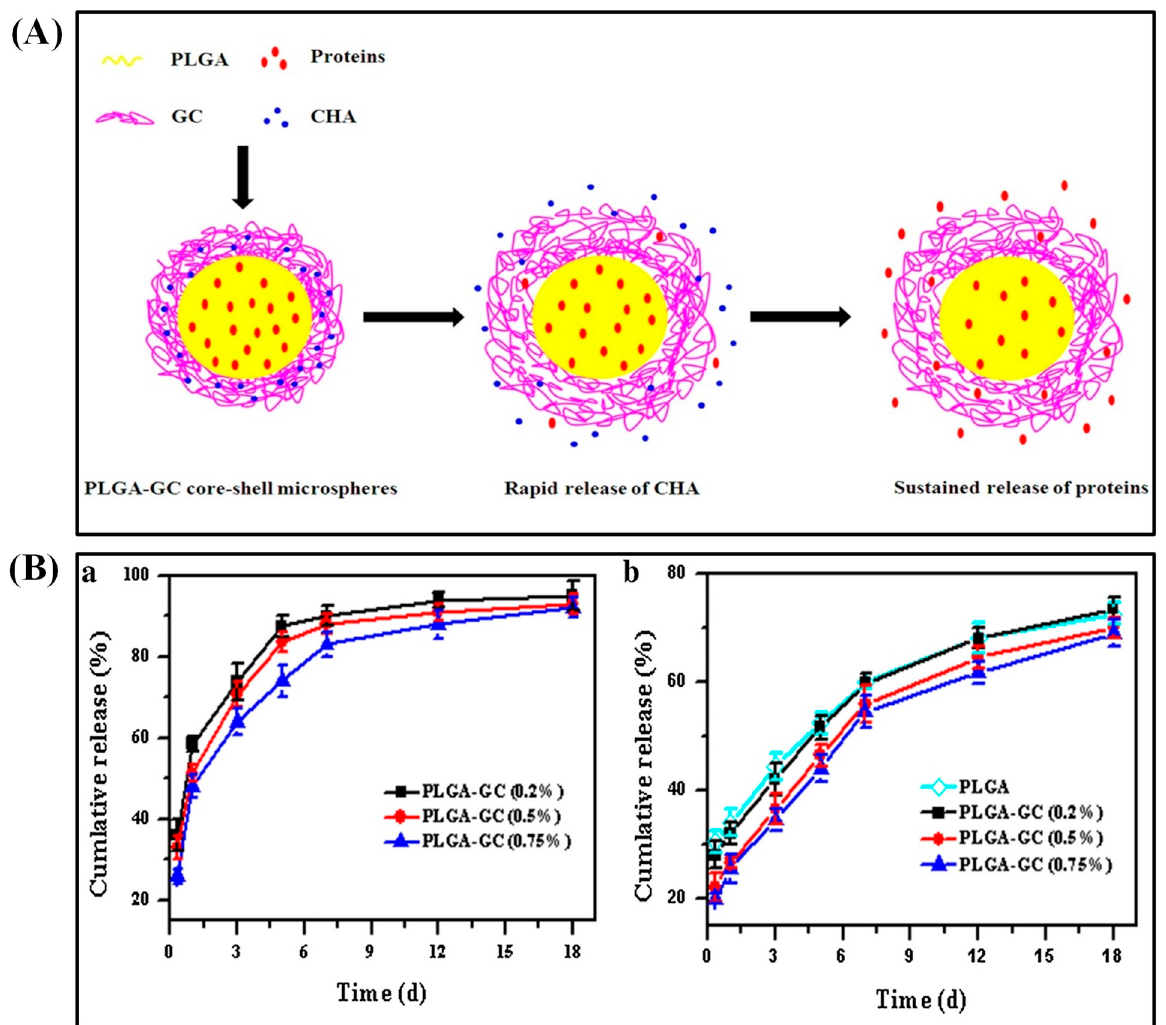
Figure 2. Schematic diagram of the co-delivery mechanism of CHA and proteins from the PLGA–GC core–shell microvehi- cles ( A ). In vitro release profiles of CHA and BSA from PLGA–GC microspheres ( B ). Reproduced with permission from [37].